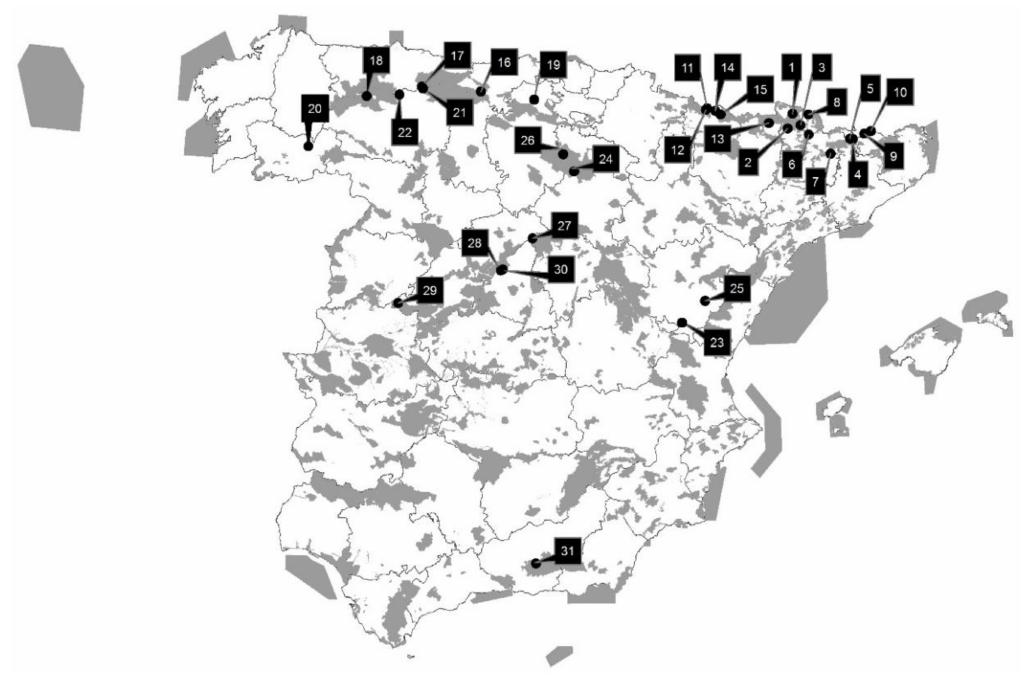
Figure A2. Map of alpine ski resorts and ZEPA sites in Spain. Source: Based on http://www.magrama.gob.es/es/biodiversidad/servicios/banco-datos-naturaleza/informacion- disponible/rednatura_2000_zepa_descargas.aspx (accessed in December 2015). Legend: Same information as Figure 1.